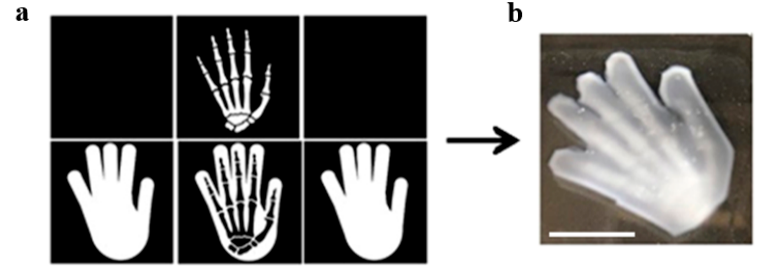
Figure 35. ( a ) Arbitrary scale DLP projection images; upper design (bones) printed with UV light, lower design printed with visible-light. ( b ) Multi-material DLP 3D printed hand using UV and visible light projections. Scale bar represents 25 mm. Reproduced from [320].